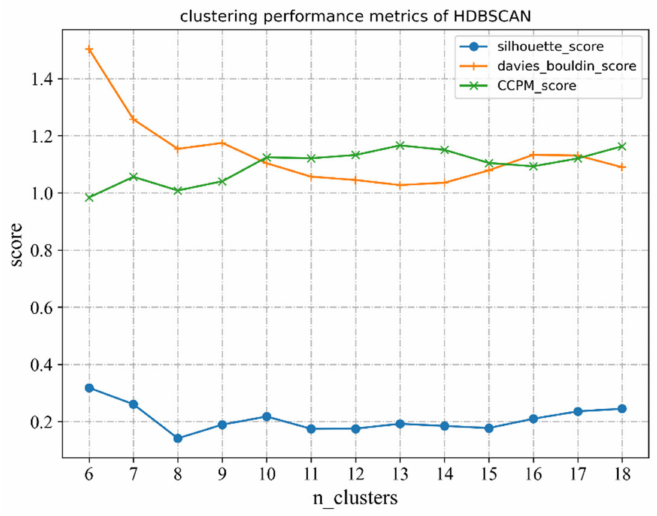
Figure 9. Clustering performance metrics of the proposed